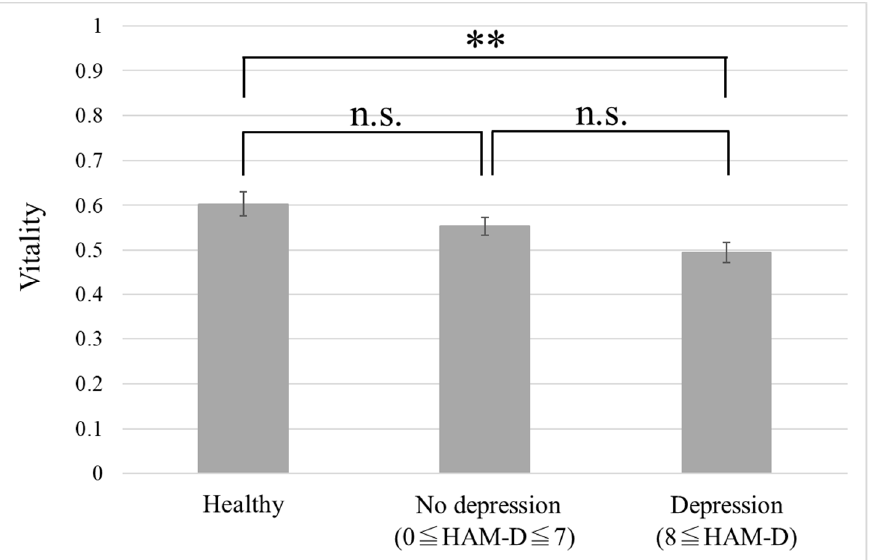
Figure 4. Comparison of vitality for each group. Error bars represent standard error. ** p < 0.01, n.s.: not significant. HAM-D: Hamilton Rating Scale for Depression.